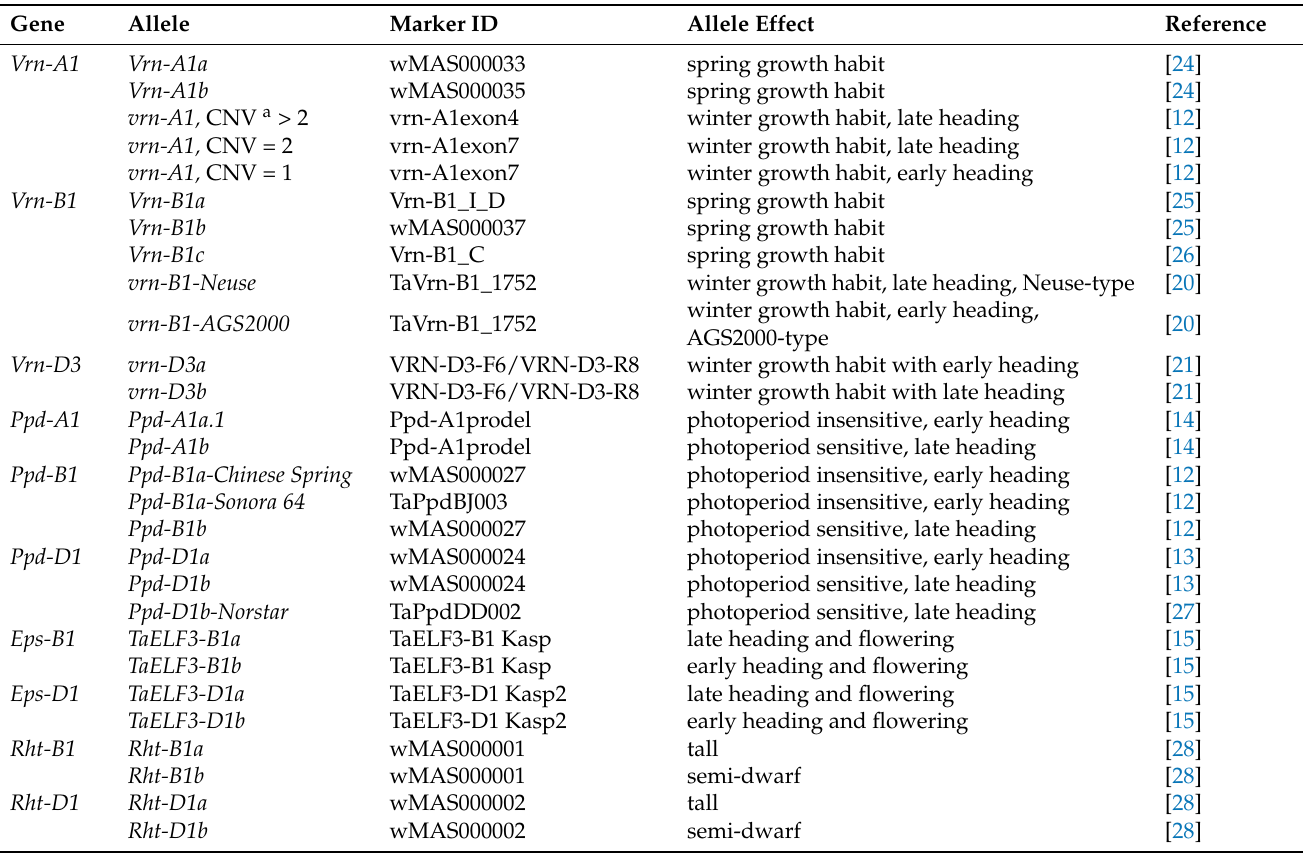
Table 6. Alleles of vernalization ( Vrn ), photoperiod ( Ppd ), earliness per se ( Eps ) and reduced-height ( Rht ) genes governing the heading date of